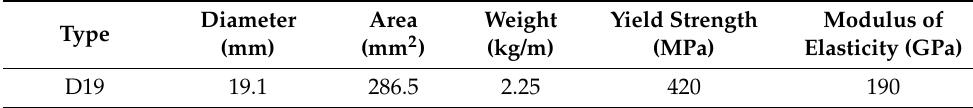
Figure 2. Specimen geometries (dimensions in mm). Table 2. Material properties of steel bar.